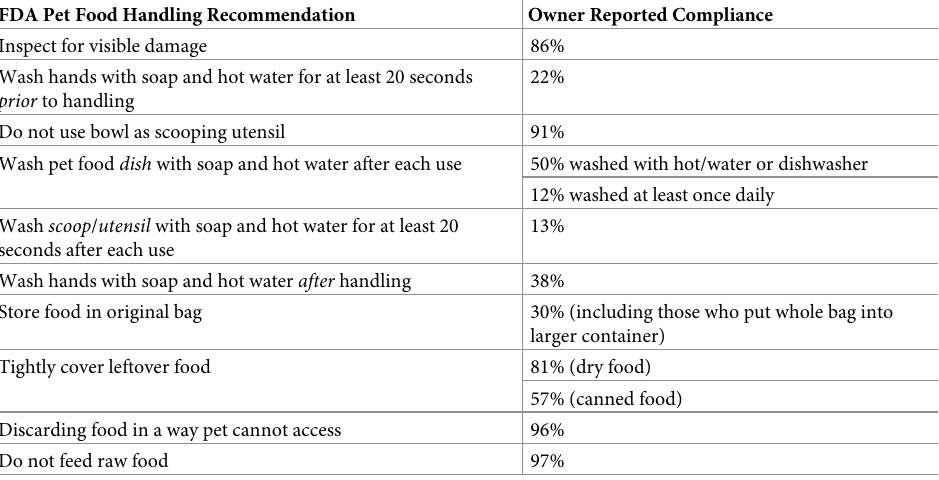
Table 1. FDA pet food handling recommendation and owner reported